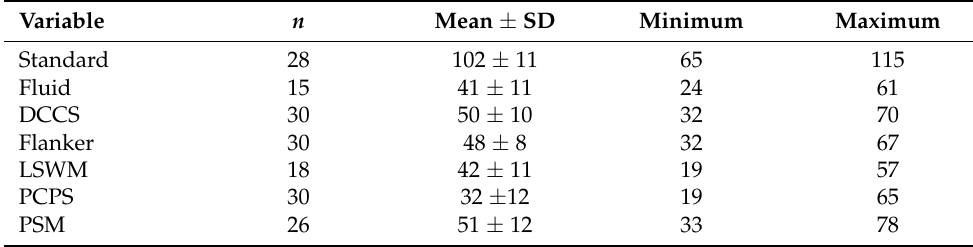
Table 4. Child cognitive scores at 1–5 years of age.